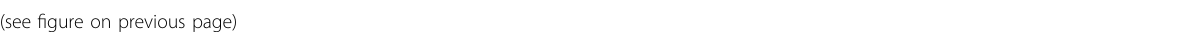
Fig. 3 SCA1-High-FAPs differentiate more ef fi ciently into adipocytes than SCA1-Low-FAPs. a Experimental design to induce adipogenic differentiation of mdx FAP cell states. GM = growth medium; AIM = adipogenic induction medium; MM = maintenance medium. b and c Bar plots showing the percentage of ORO positive cells and PPAR-gamma positive cells per fi eld. AM = adipogenic medium (AM = AIM + MM). Statistical analysis was performed by a Two-way ANOVA ( n = 4). d Representative micrographs of ( b ) and ( c ). Cells were immunolabelled for PPAR-gamma (yellow) and nuclei were counterstained with Hoechst 33342 (blue). Lipid droplets were stained with ORO (red). e Experimental design applied to obtain fully differentiated adipocytes. f Bar plot indicating the percentage of ORO positive cells (n = 3). Statistical signi fi cance was calculated through Student ’ s t test. g Representative micrographs of (f) . Lipid droplets in red (ORO staining) and nuclei in blue (Hoechst 33342). h Representative viSNE maps showing the expression of SCA-1 and phospho-CREB-1 assessed by mass cytometry in FAPs isolated from mdx mouse by MACS and cultured 72 h either in GM or AIM ( n = 3). i Cluster 1 (in blue) and cluster 2 (in orange) obtained applying the FlowSOM algorithm and then mapped onto viSNE maps. j Plot representing the expression in arbitrary units of SCA-1 and phospho-CREB-1 identi fi ed in ( i ). Data are presented as mean ± SEM. ** p ≤ 0.01, *** p ≤ 0.001. Scale bars 100 μ